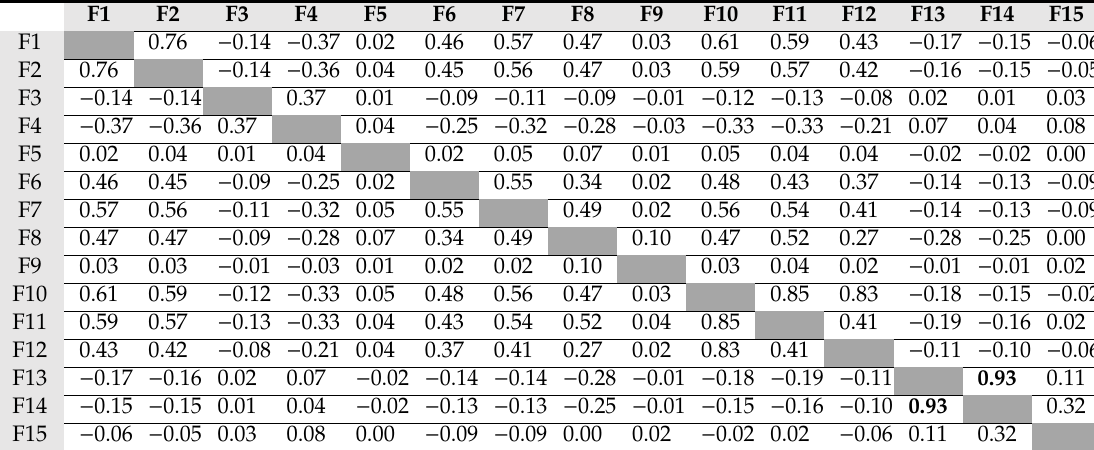
Table 3. Pairwise correlation for 15 potential features based on selected samples. The bold number shows the high correlation, with r >